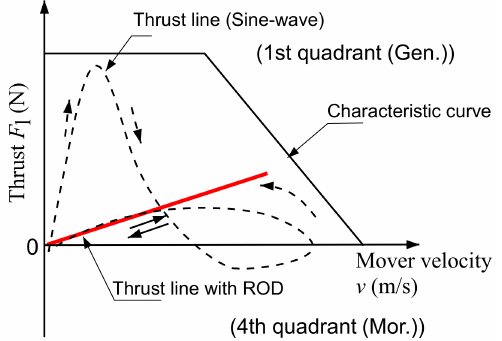
Figure 4. Characteristic curve of a linear generator.